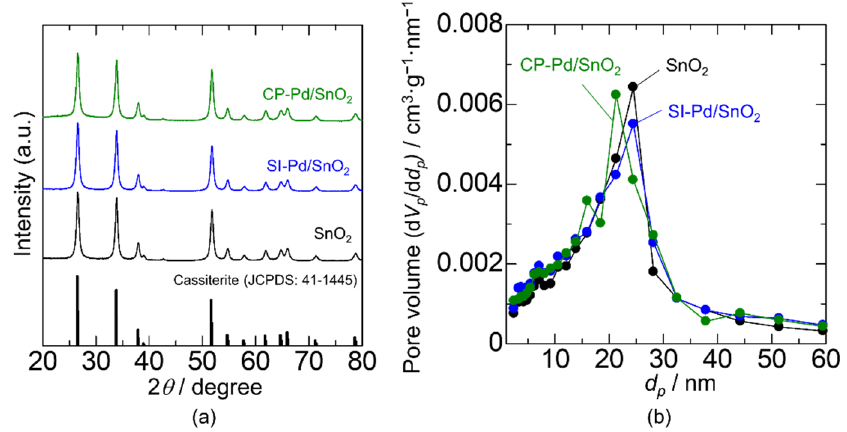
Figure 4. ( a ) XRD patterns and ( b ) pore distribution-based BJH estimation for SnO 2 , SI-Pd/SnO 2 , and CP-Pd/SnO 2 .